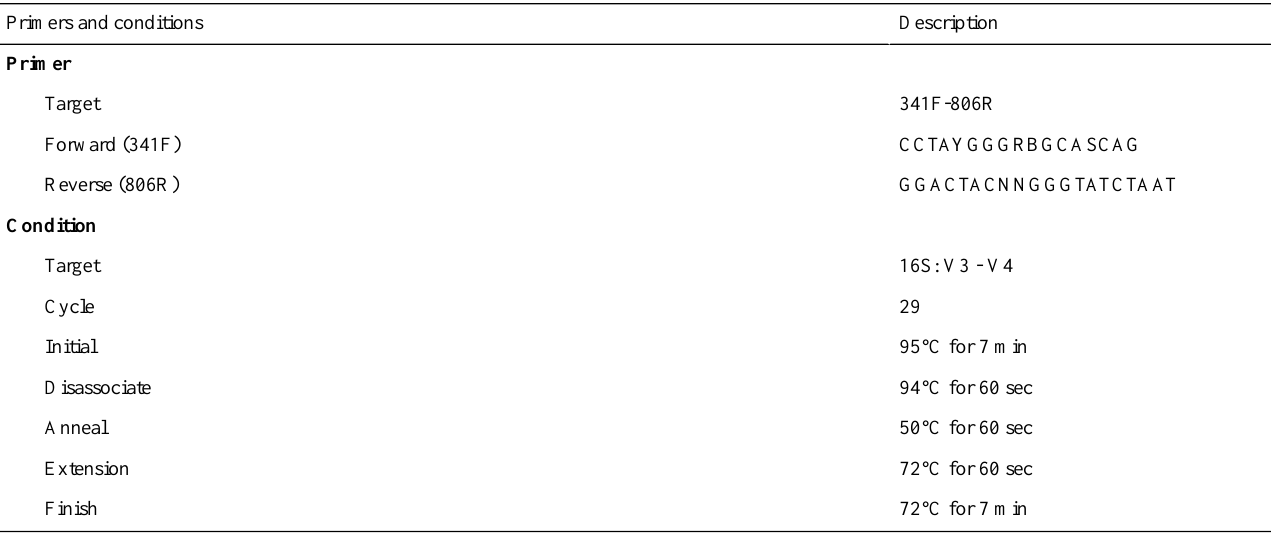
Table 1. Primers and conditions used to amplify the 16S: V3-V4 target sequence.